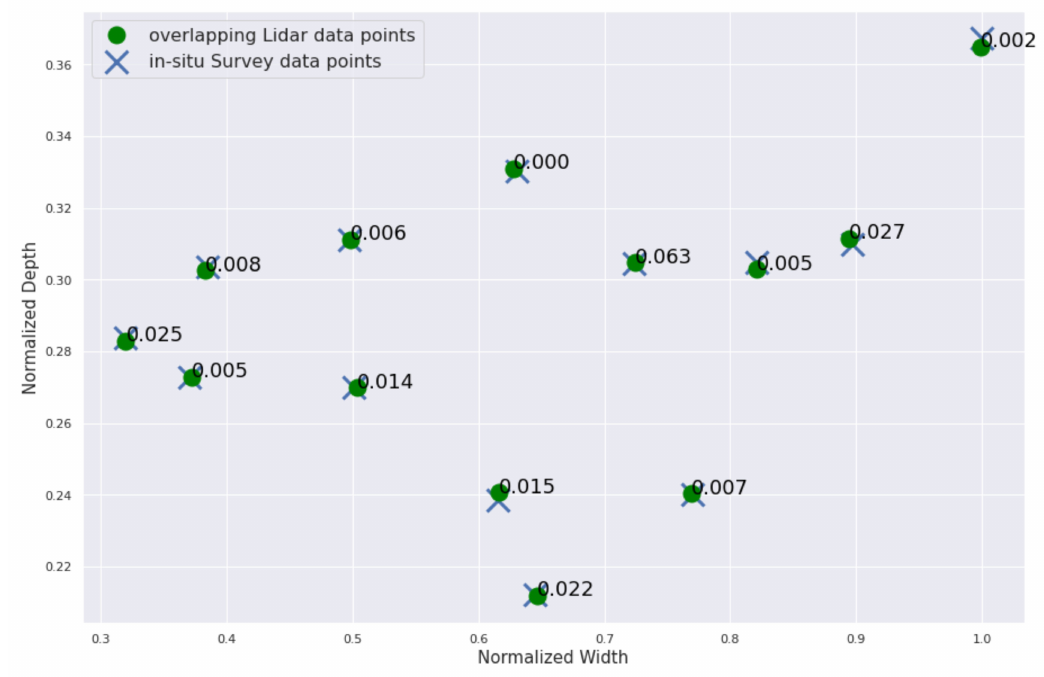
Figure 10. Difference between Lidar and in situ survey data in meters.